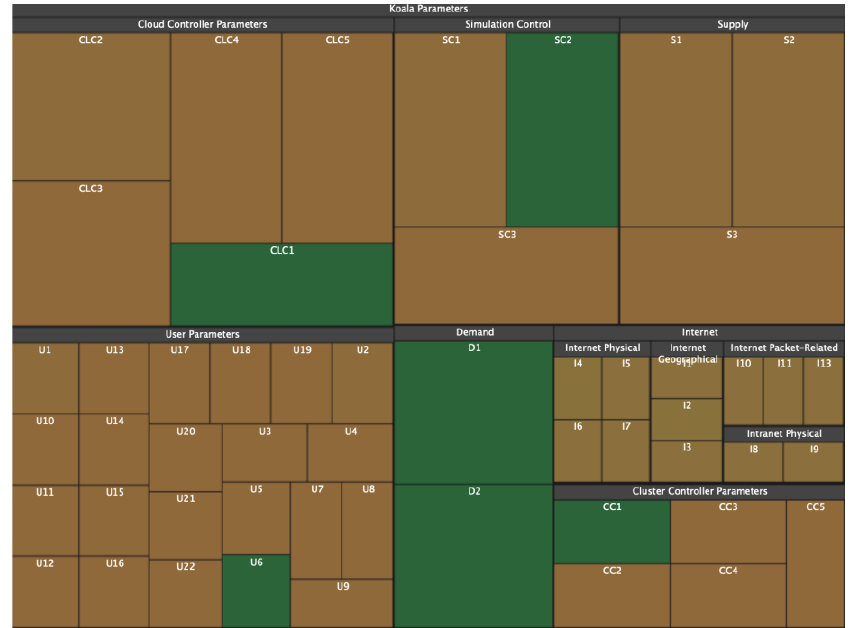
Figure 6. The tree shown in Figure 5 but redrawn using squarified treemaps [43]. It is noticeable that the desire for the equilateralness of rectangles gives rise to the complexity of determining hierarchical